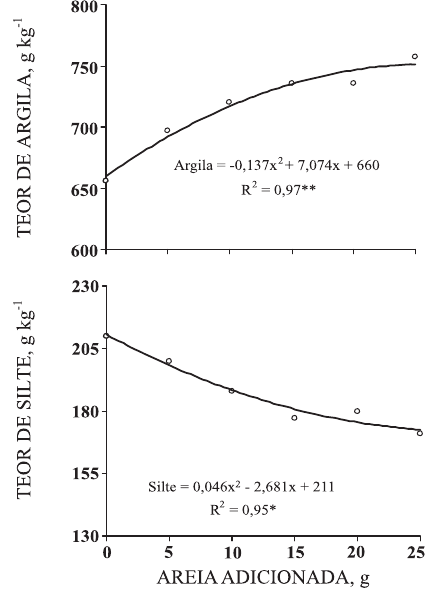
Figura 2. Efeito da adição de areia nos teores de argila e silte do Nitossolo Vermelho eutroférrico (NVef). * e **: significativos (p < 0,05) e (p < 0,01), respectivamente.